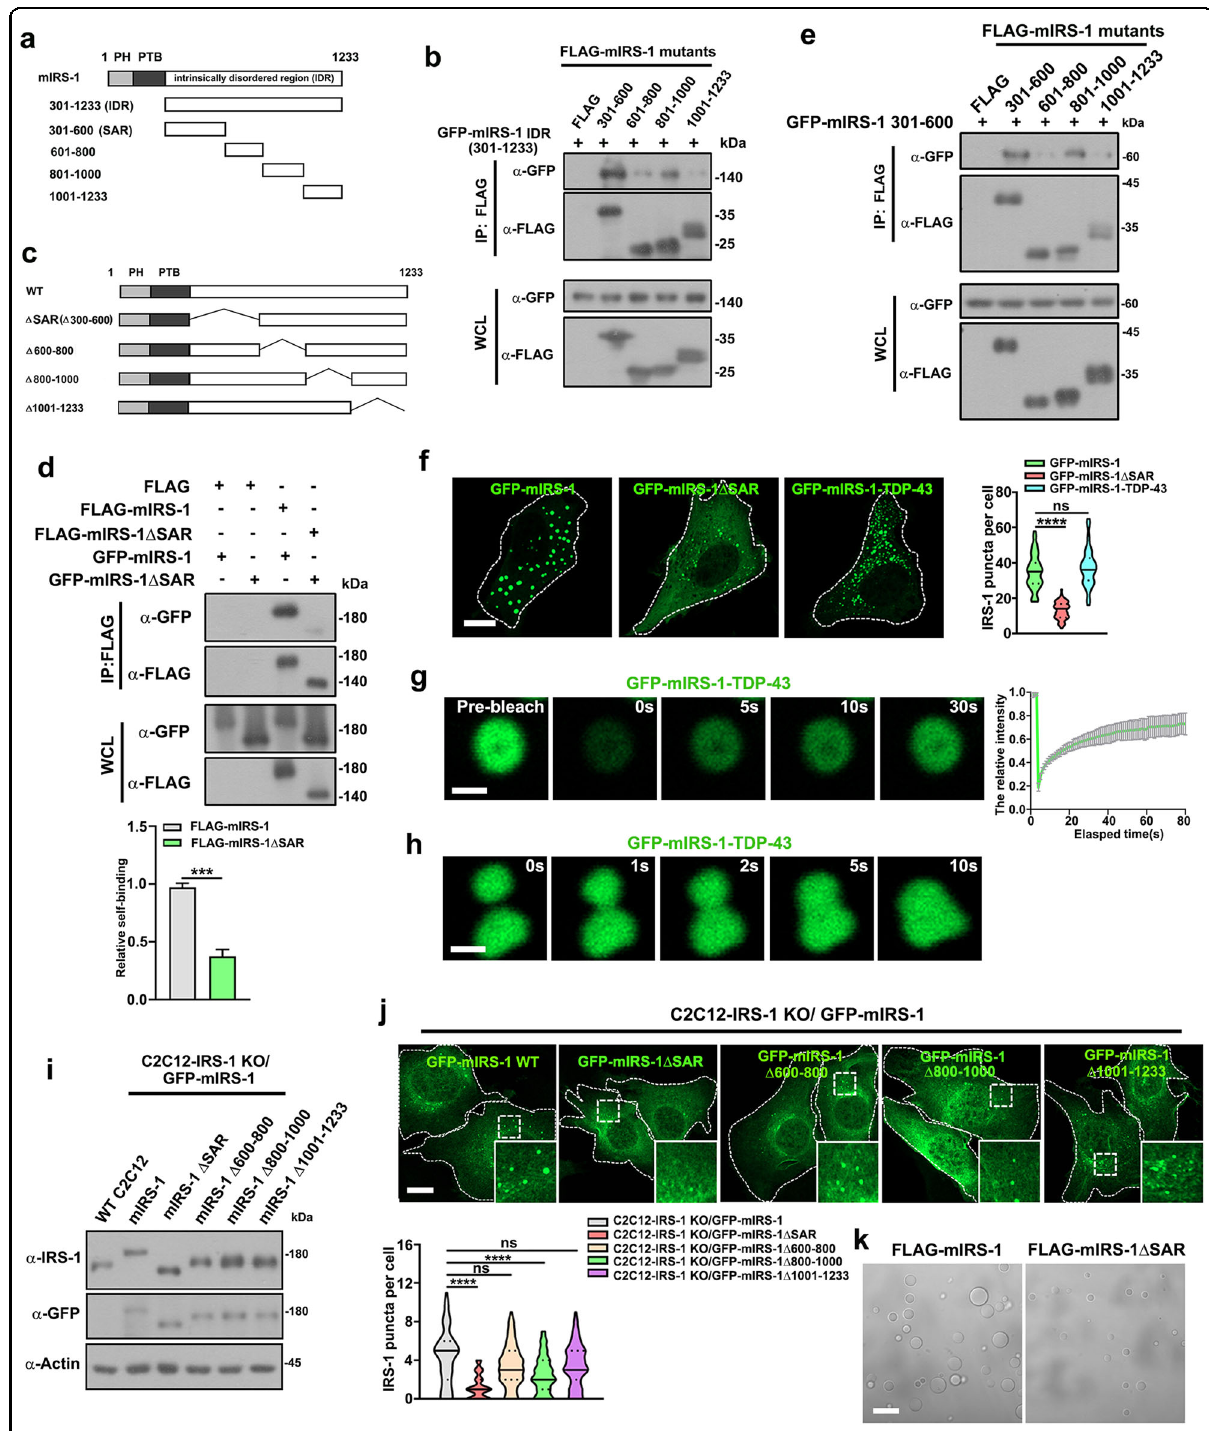
Fig. 3 (See legend on next